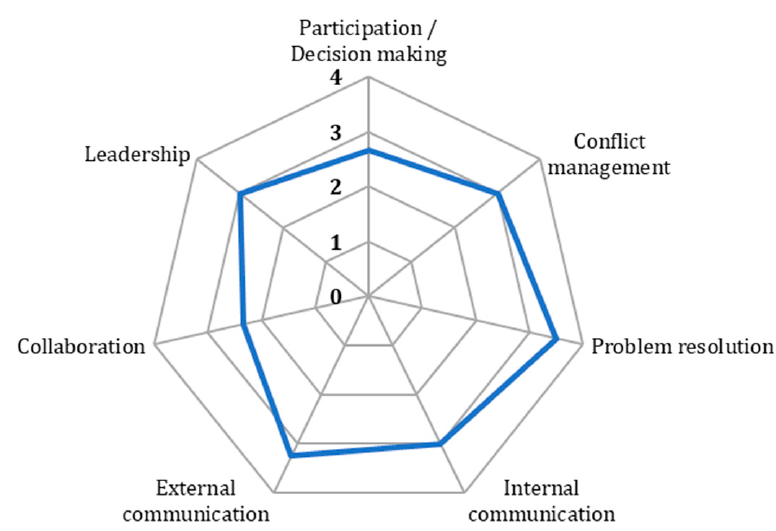
Figure 2. Example of a trace for a working group.